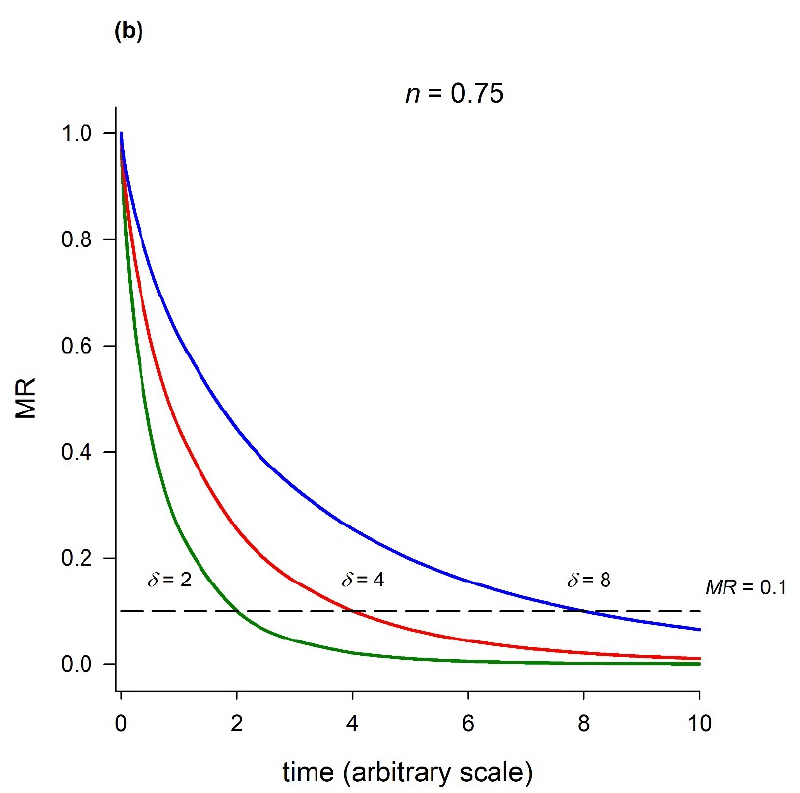
Figure 6. Effect of shape parameter ( n ) on the drying curves’ shape ( a ) and effect of time parameter ( δ ) on the drying curves’ shape ( b ) given by Equation (11). The unit of time is whether min or